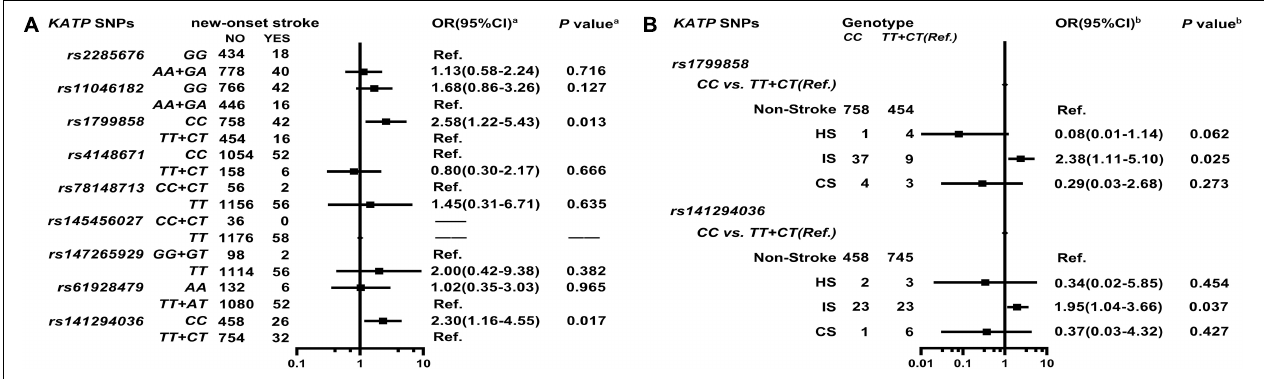
FIGURE 3 | Association of KATP SNPs with the new-onset of stroke in the study participants. a Model (A) After adjustment for gender, age, smoking, alcohol consumption, BMI, WBC, blood glucose levels (FBS, P2hBS and HbA1C), liver function (ALT, AST and Alb), renal function (Scr, BUN and UA), serum sodium and potassium levels, HsCRP, RAAS activity (ACE, renin, Ang I, Ang II, and ALD), dyslipidemia [TRIG, TC, LDL-C, ApoB, HDL-C, ApoA-I and Lp(a)], medical condition [T2D, EH, CAD(ACS), AF, and LCI], NYHA functional classification, and echocardiography index (RVD, RAD, LVD, LAD, and LVEF), and combined medication (antiplatelet drugs, warfarin, statins, RSIs, BBs, MRA, CCBs, diuretics, digoxin, nitrates, and hypoglycemic agents). b Model (B) It is the same as Model (A) .